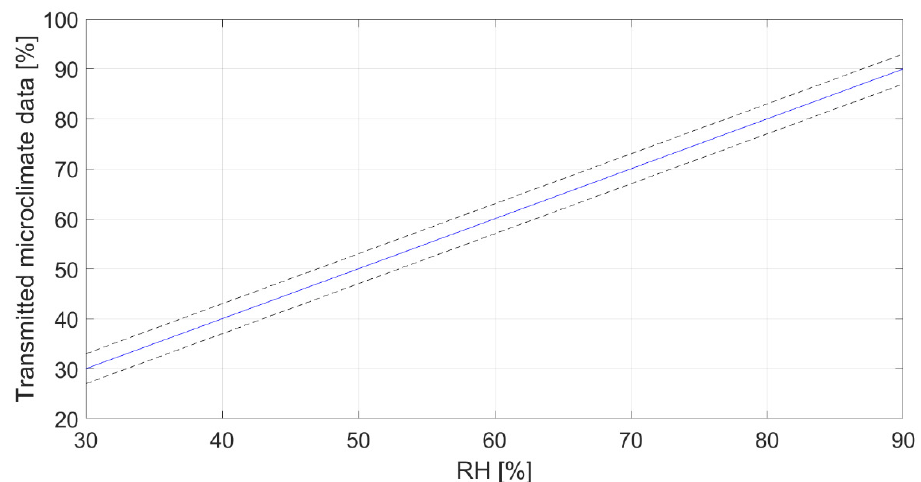
Figure 7. Characterization in terms of relative humidity at 20 °C.